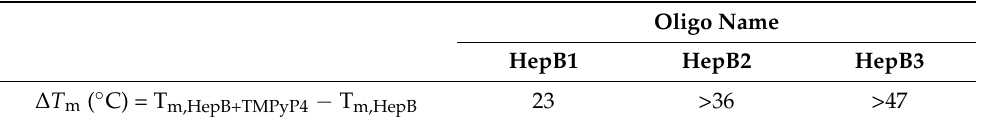
Table 4. Temperature stabilization of HepB variants by the cationic porphyrin TMPyP4. All experi- ments were performed in the presence of potassium